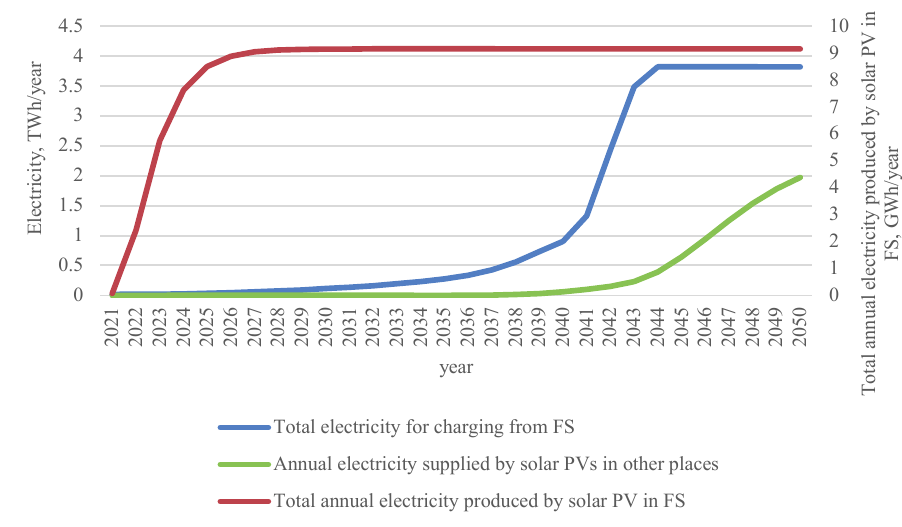
Fig. 6. Amount of the total annual electricity supplied for charging of EV from fuel stations (FS), the total annual electricity produced by solar PVs in FS (right-hand axis) and the total annual electricity produced by solar PVs in other places where the charging units are installed (left-hand axis).